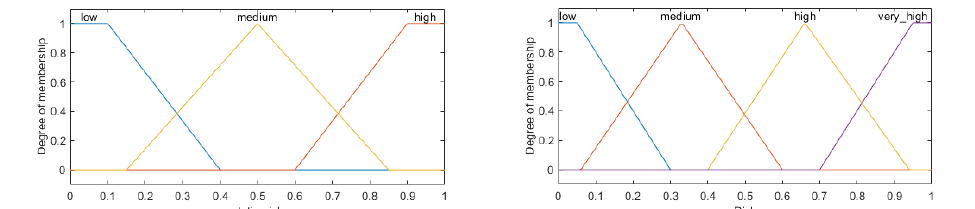
Figure 9. Membership functions of the fuzzy inference system (FIS) of input static risk ( left ) and output risk value ( right